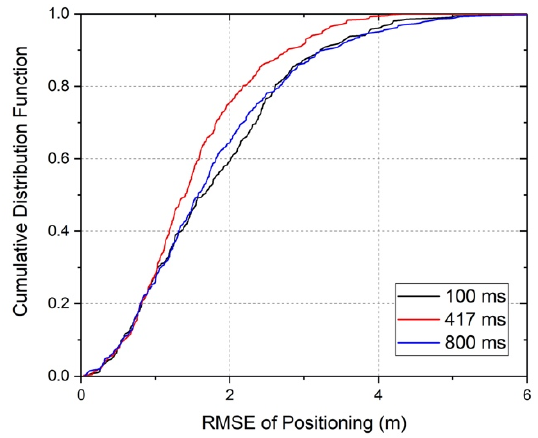
ff erent transmission